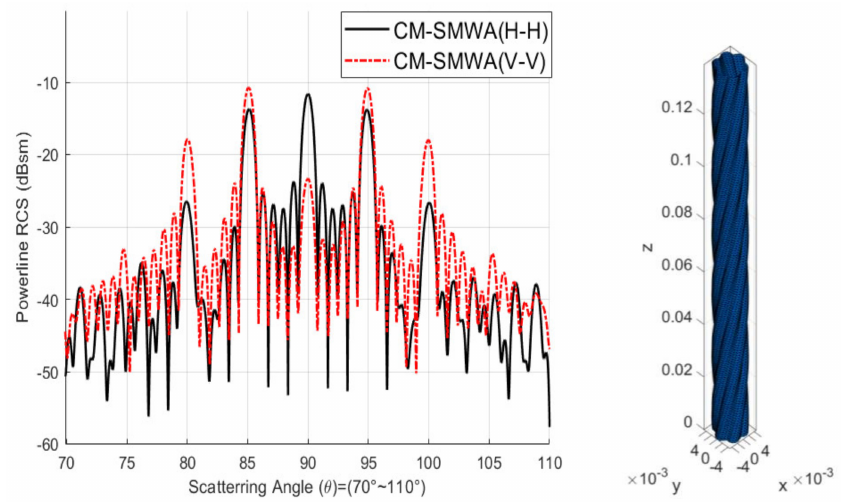
Figure 15. Simulation results of the H-H polarization vs. V-V polarization at 76 GHz.